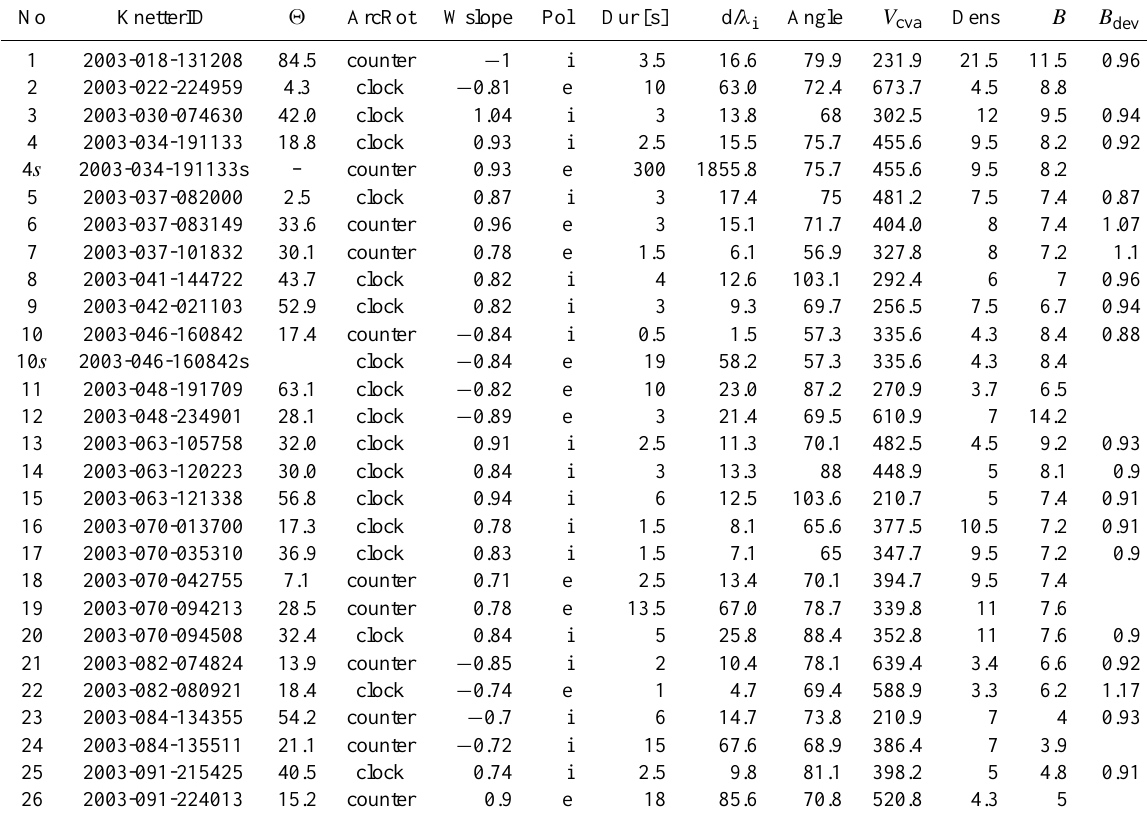
Table 1. Arc-polarized structures: Overview of parameters.